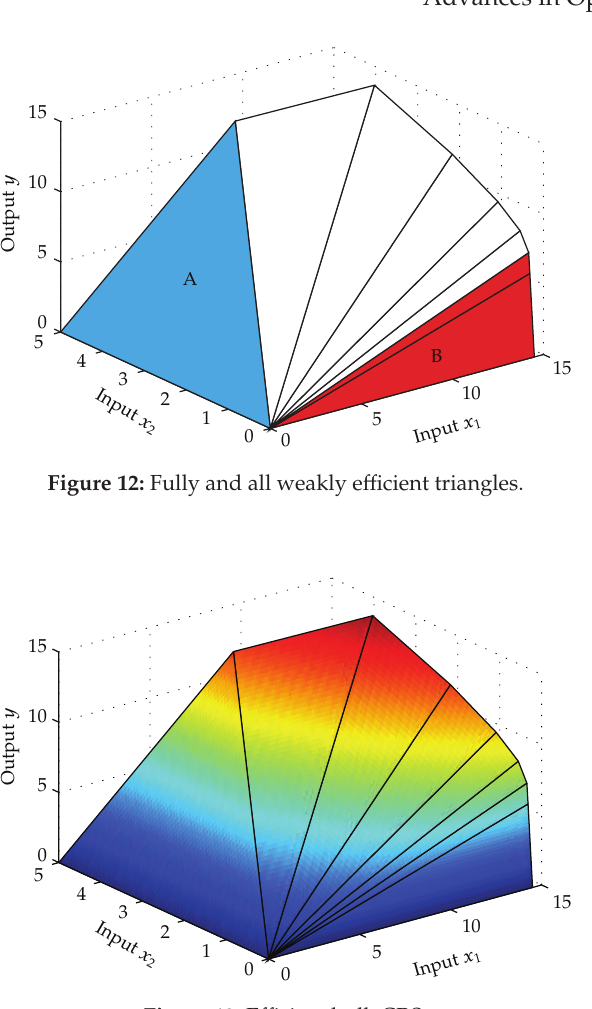
Figure 13: E ffi cient hull,